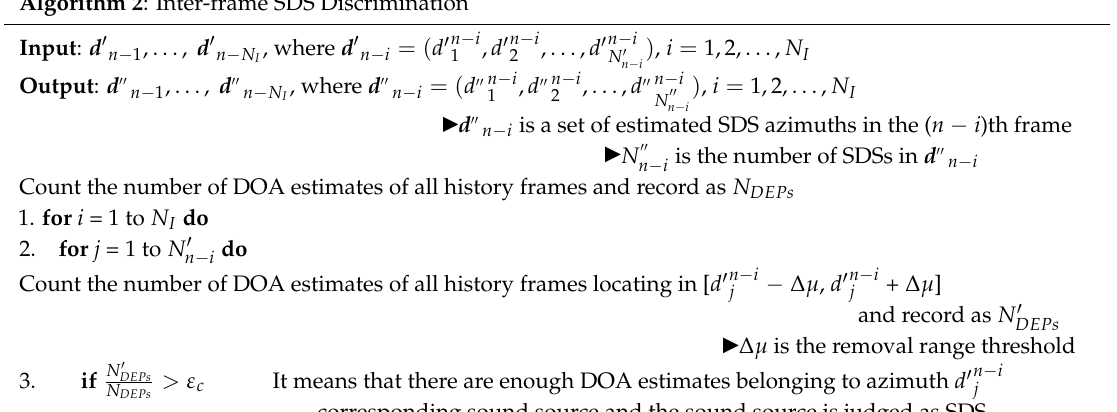
Algorithm 2 : Inter-frame SDS Discrimination Algorithm 1 : Intra-frame SDS Discrimination Algorithm 1 : Intra-frame SDS Discrimination